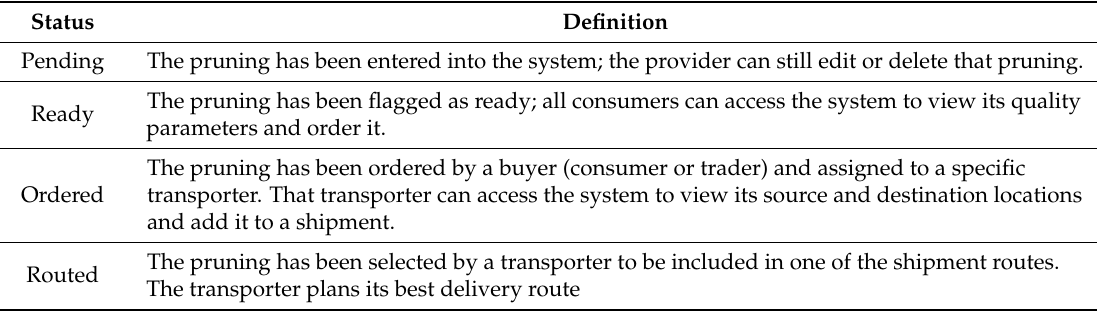
Table 2. Pruning record